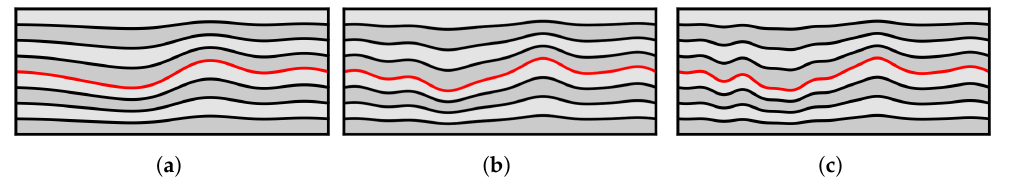
Figure 4. KLE-based waviness modeling of a generic CFRP cross-section made up of 8 layers for three different numbers of eigenvalues. The numerical approximated random field is highlighted in red. ( a ) 6 modes; ( b ) 12 modes; ( c ) 20